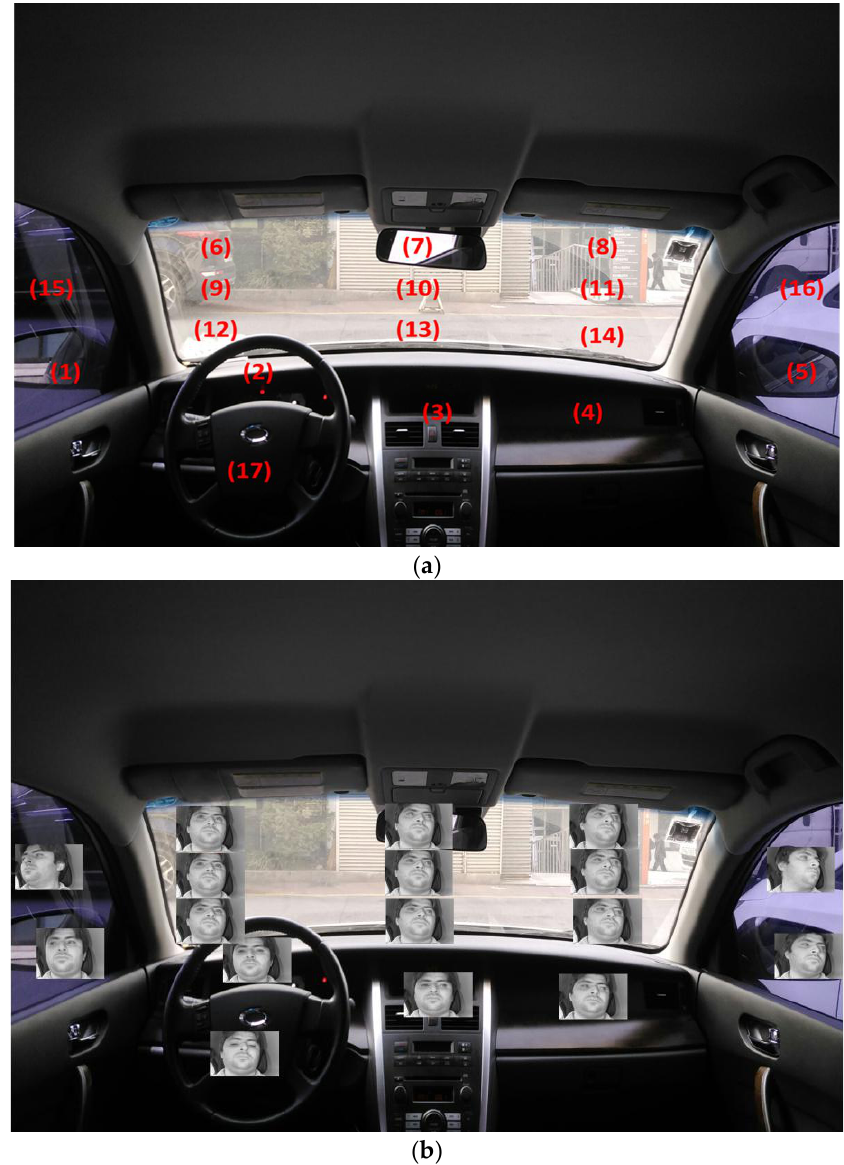
Figure 3. 17 gaze zones in our experiments. ( a ) 17 gaze zones; ( b ) Captured images when the driver looked at each gaze zone.